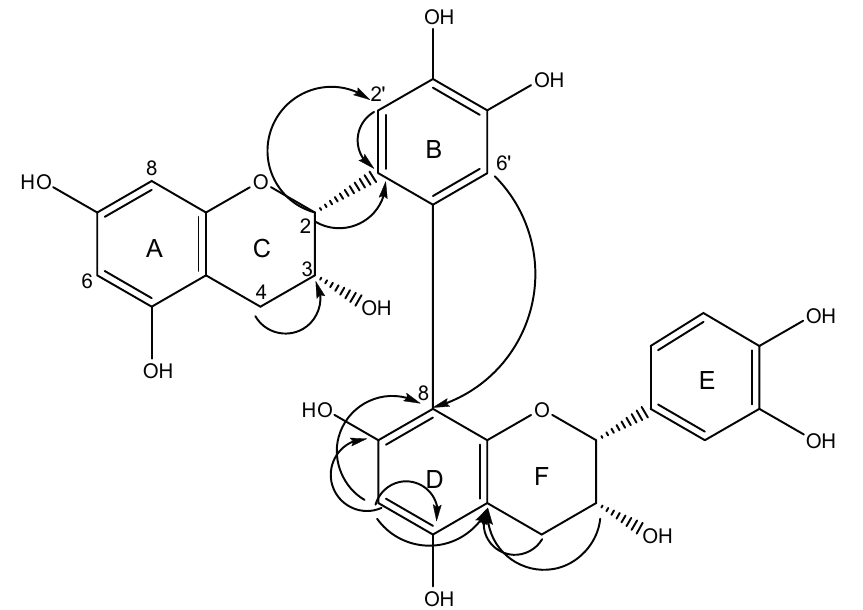
Figure 3. Structure of epicatechin-(6 ′→ 8)-epicatechin ( 5 ) isolated from C. mucronatum . Arrows indicate relevant HMBC correlations.